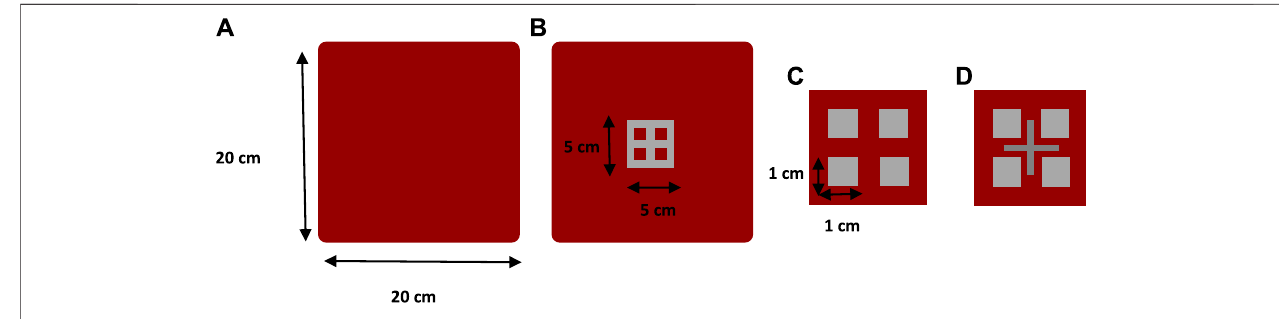
FIGURE 1 | Top-down arrangement of the fabrication of a single junction cell: (A) deposition of the p-i-n structure on the 20 cm 2 × 20 cm 2 SnO2:F/glass substrates, (B) fi xation of metal mask on the p-i-n structure and deposition of the Al back contact, (C) samples cutting, and (D) indium soldering to access to the front contact.